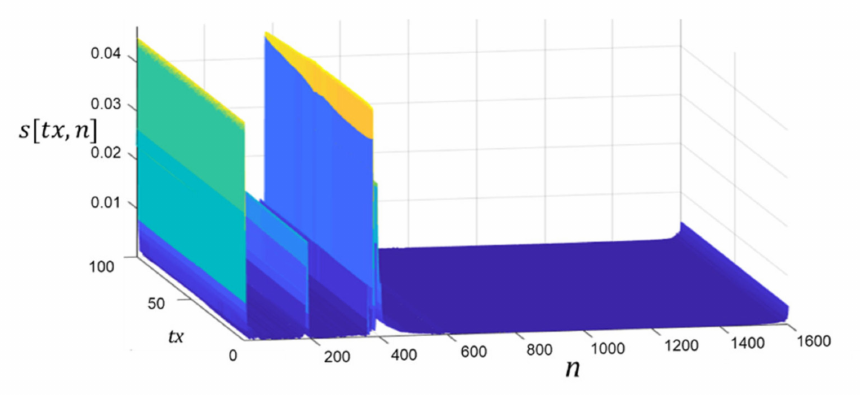
Figure 6. IFFT transformed data acquired from scan